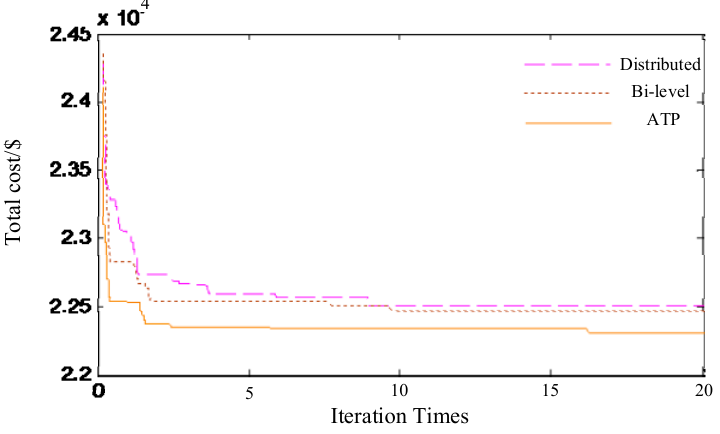
Figure 8. Algorithm convergence curve comparison.